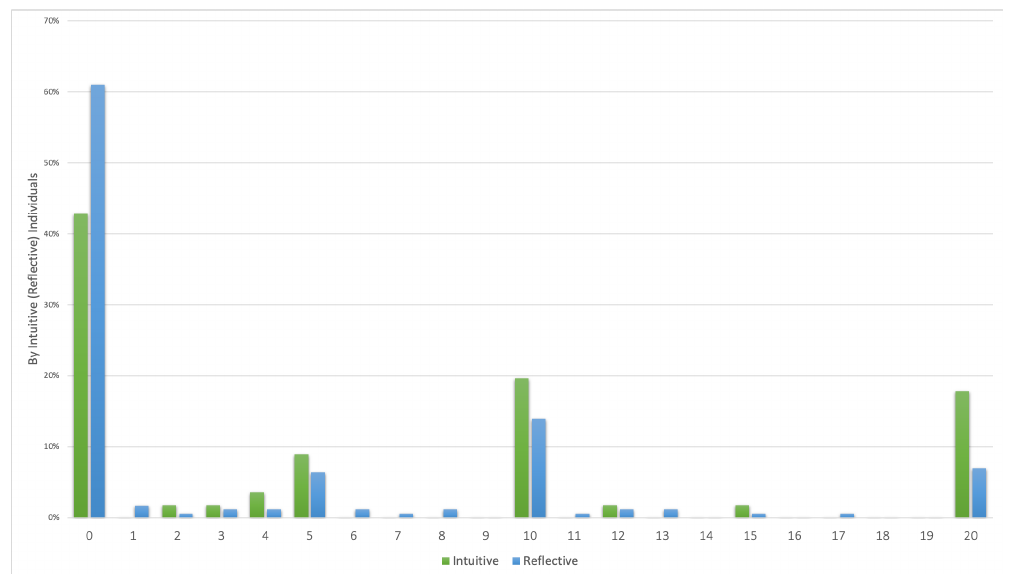
Figure A5. Frequency of Punishments Sacrifice by Intuitive (Reflective) Individuals.